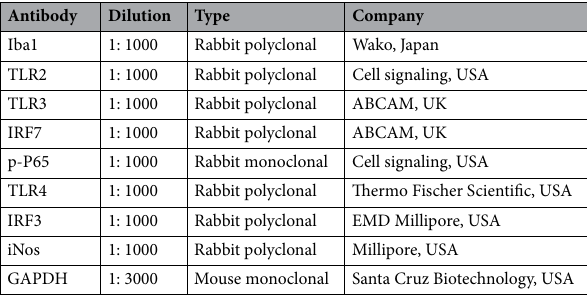
Table 2. List of antibodies for western